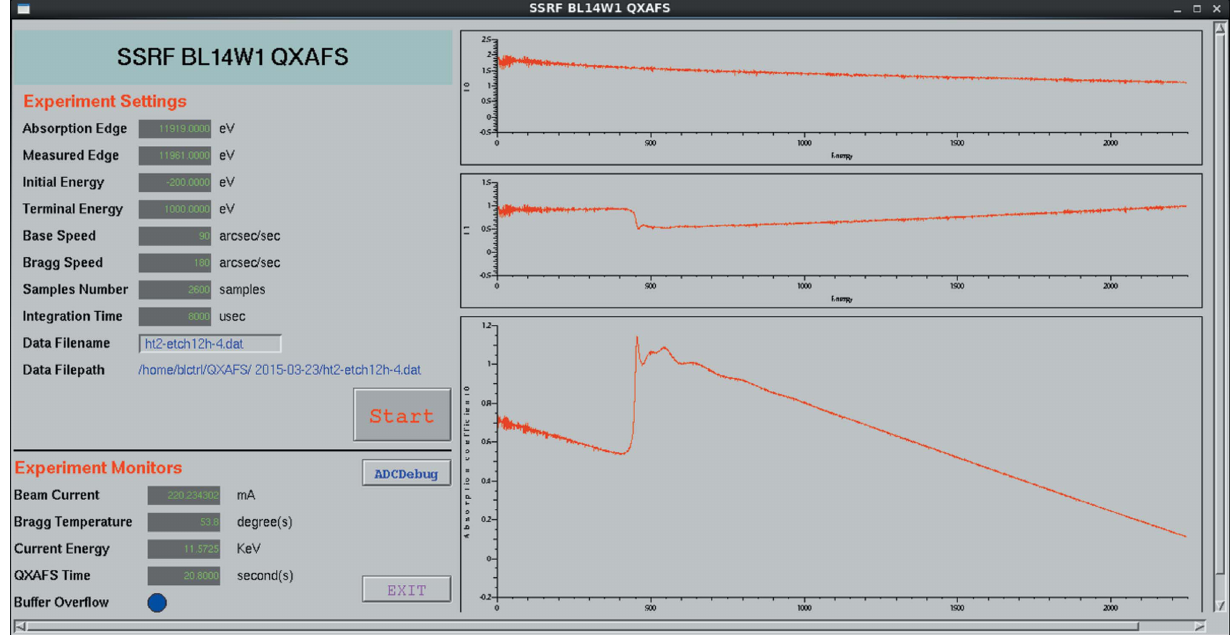
Figure 6 Main GUI of the QEXAFS Table 3 Experimental conditions used in this work.